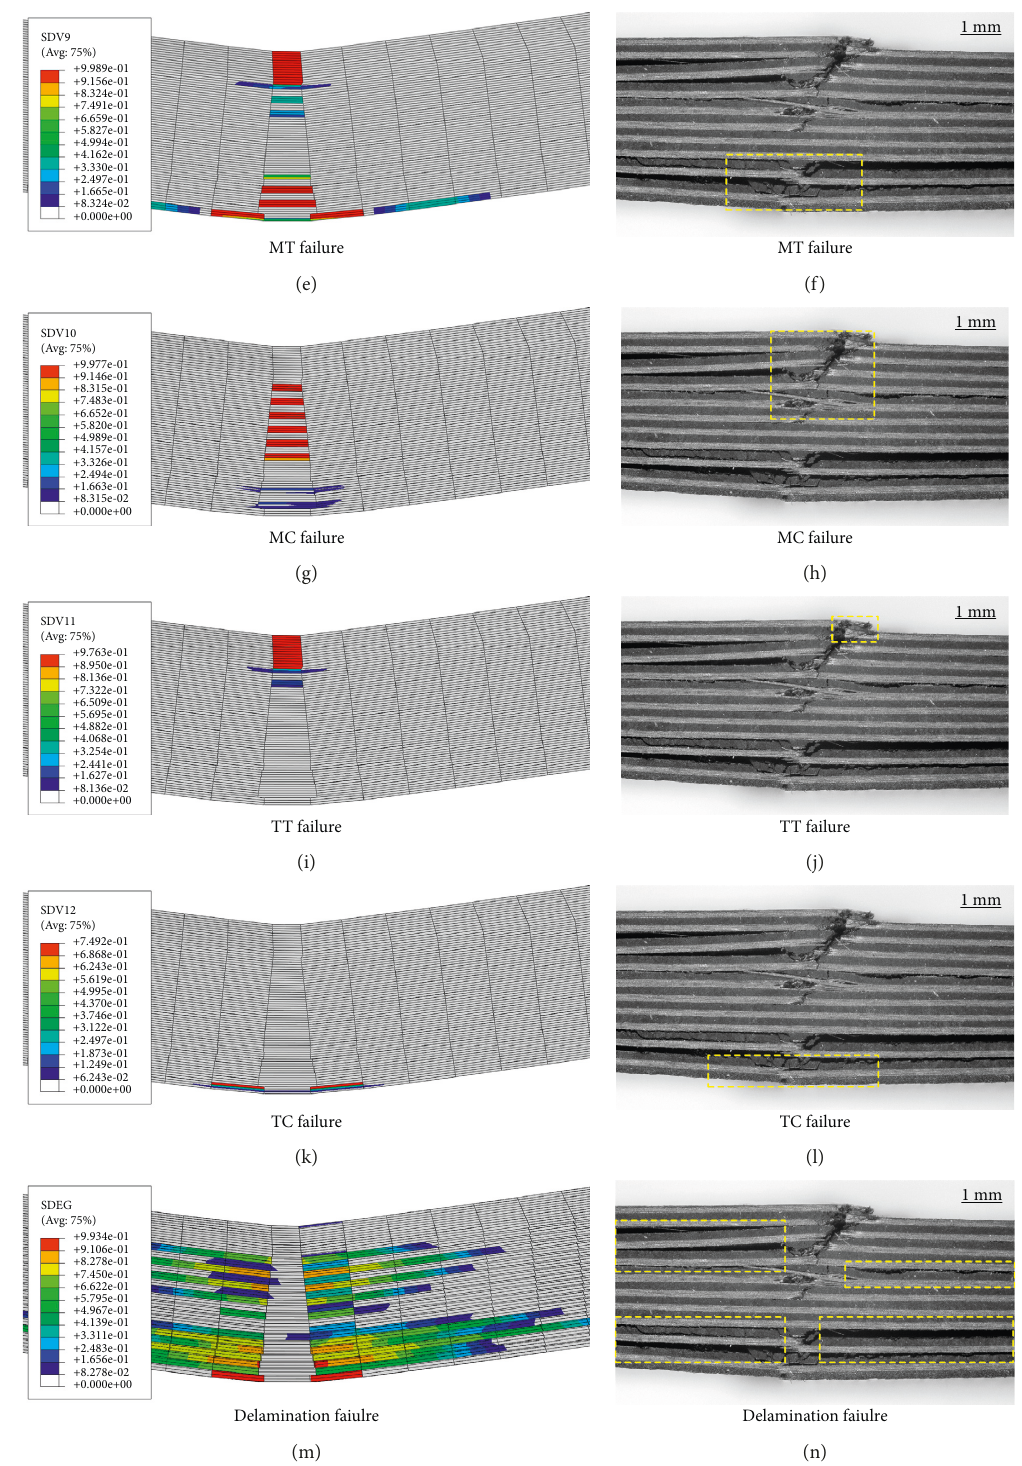
Figure 8: Failure modes at characteristic point E. (a) FTfailure, (b) FTfailure, (c) FC failure, (d) FC failure, (e) MTfailure, (f) MTfailure, (g) MC failure, (h) MC failure, (i) TT failure, (j) TT failure, (k) TC failure, and (l) TC